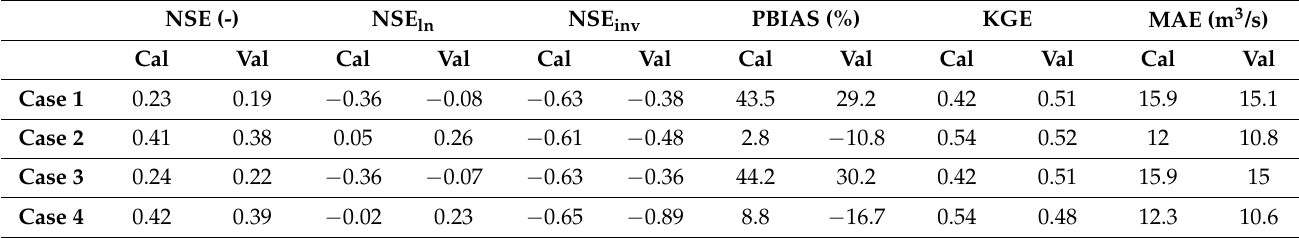
Table 3. Performance assessment of the different cases.